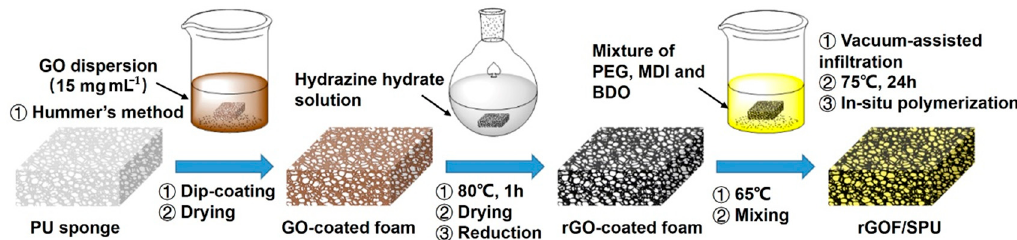
Figure 1. Schematic illustration of the synthetic route to preparing the reduced graphene oxide (rGO)-coated foam (rGOF)/segmented polyurethane (rGOF/SPU) composite. PU, polyurethane.